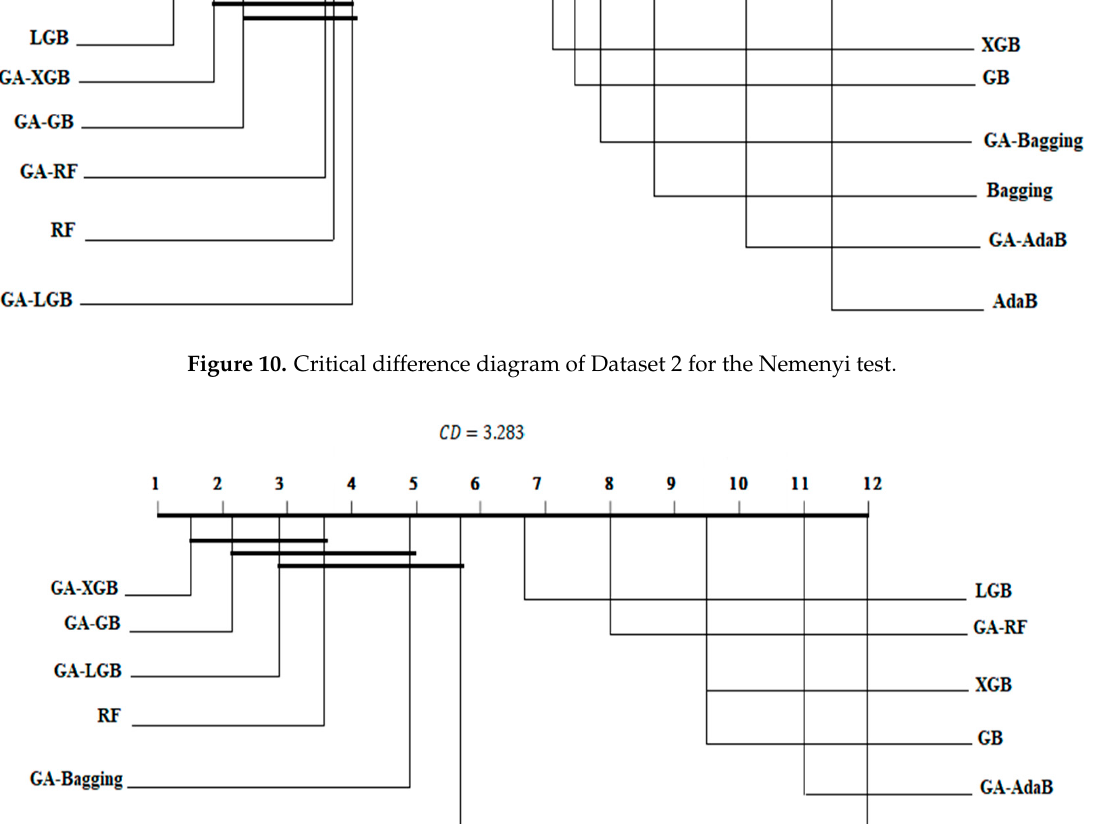
Figure 10. Critical difference diagram of Dataset 2 for the Nemenyi test.